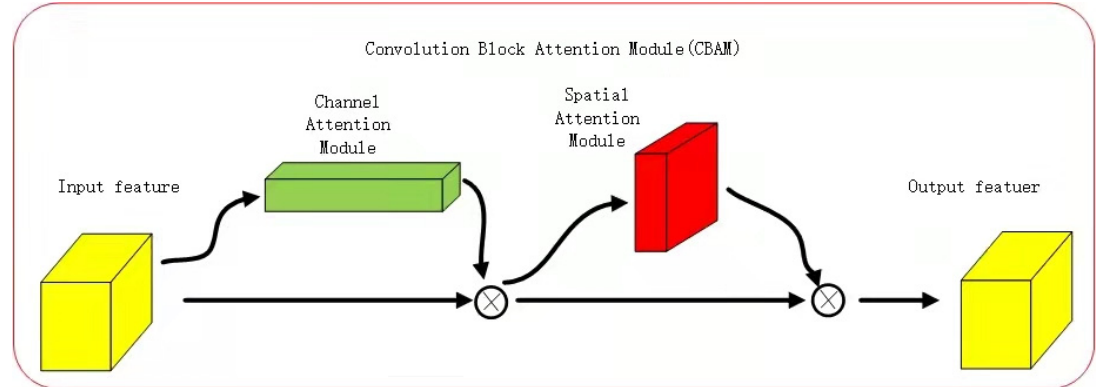
Figure 5. Structure diagram of the CBAM module.